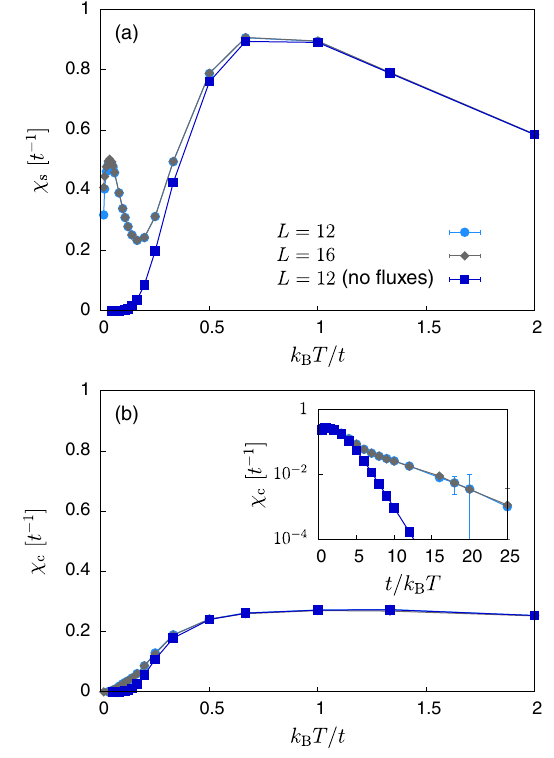
FIG. 11. (a) Spin and (b) charge susceptibility of the Kane-Mele-Hubbard model ( (cid:4)=t ¼ 0 : 2 , (cid:5) ¼ 0 ) at U=t ¼ 4 . We consider L (cid:4) 12 lattices with L= 2 (cid:1) fluxes arranged in a periodic one-dimensional chain. The inset in (b) shows the charge susceptibility as a function of inverse temperature on a logarithmic scale. The key in (a) applies to all panels.